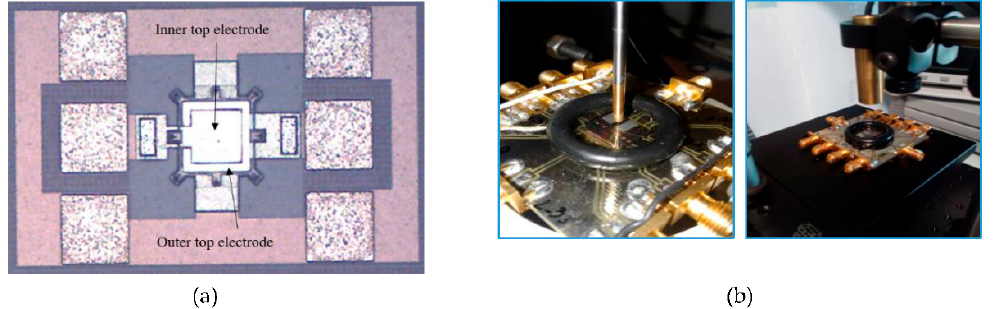
Figure 1. ( a ) Optical image of the squared 80 μ m PMUT device. ( b ) Setup for the acoustic characterization in a liquid environment as an actuator with hydrophone (left) and as a sensor with a commercial ultrasound transducer (right).